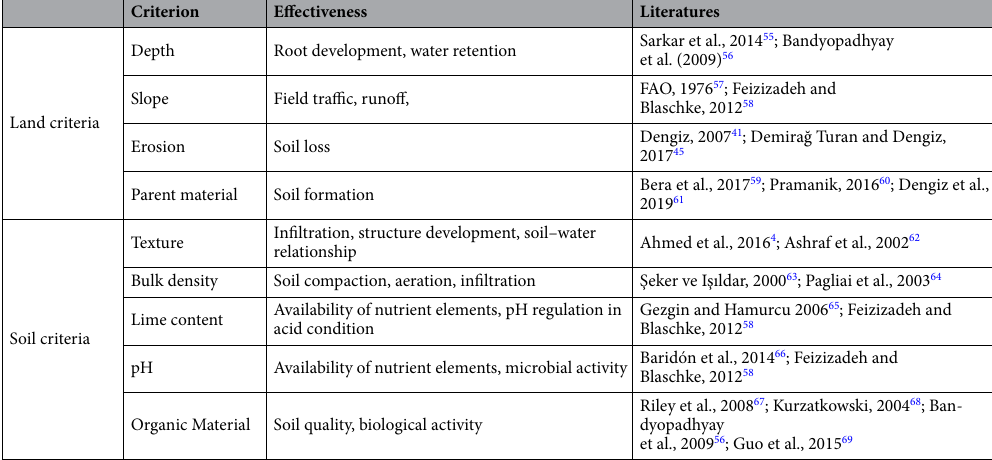
Table 1. Selected criteria for land suitability for agricultural usage and their effectiveness.